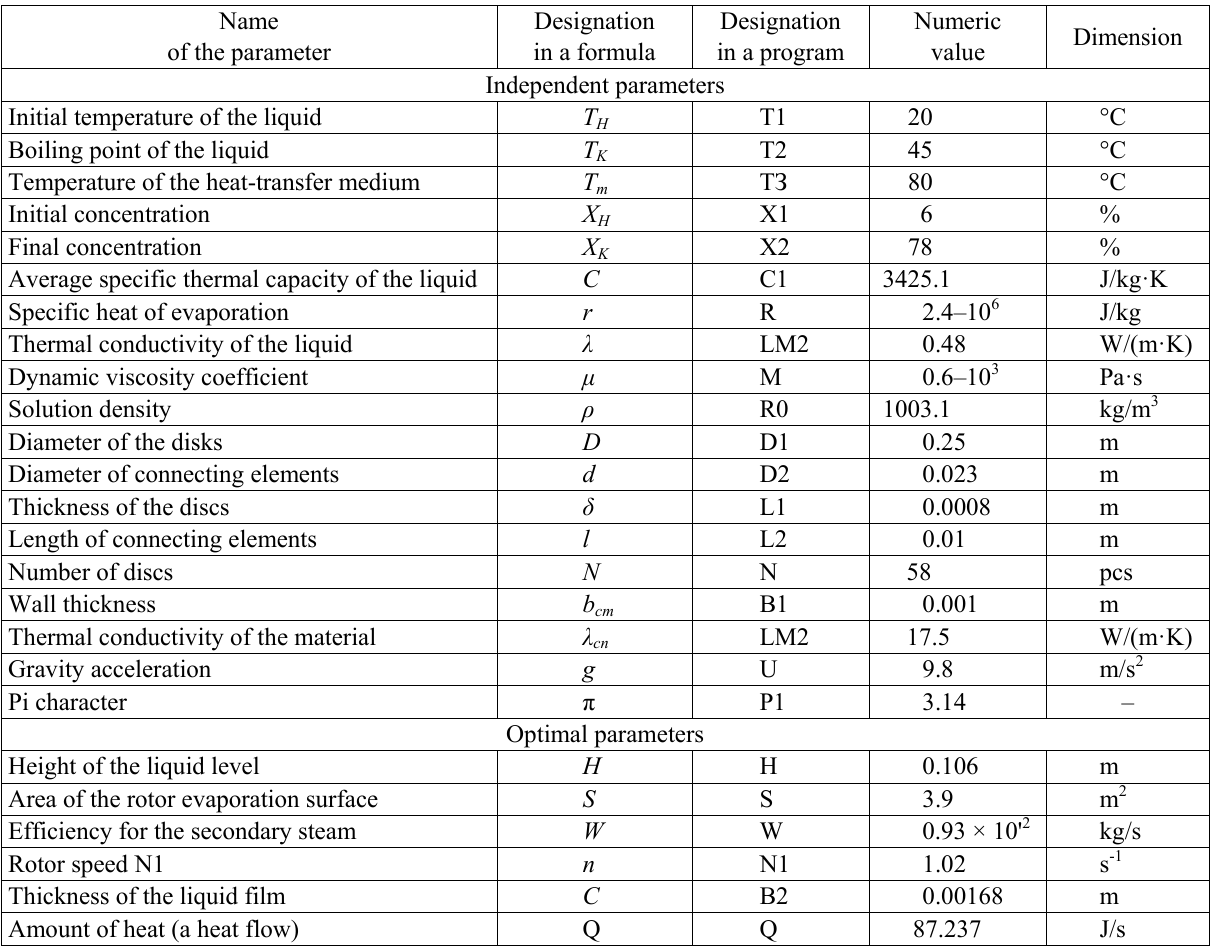
1 Table 2. Summary table of